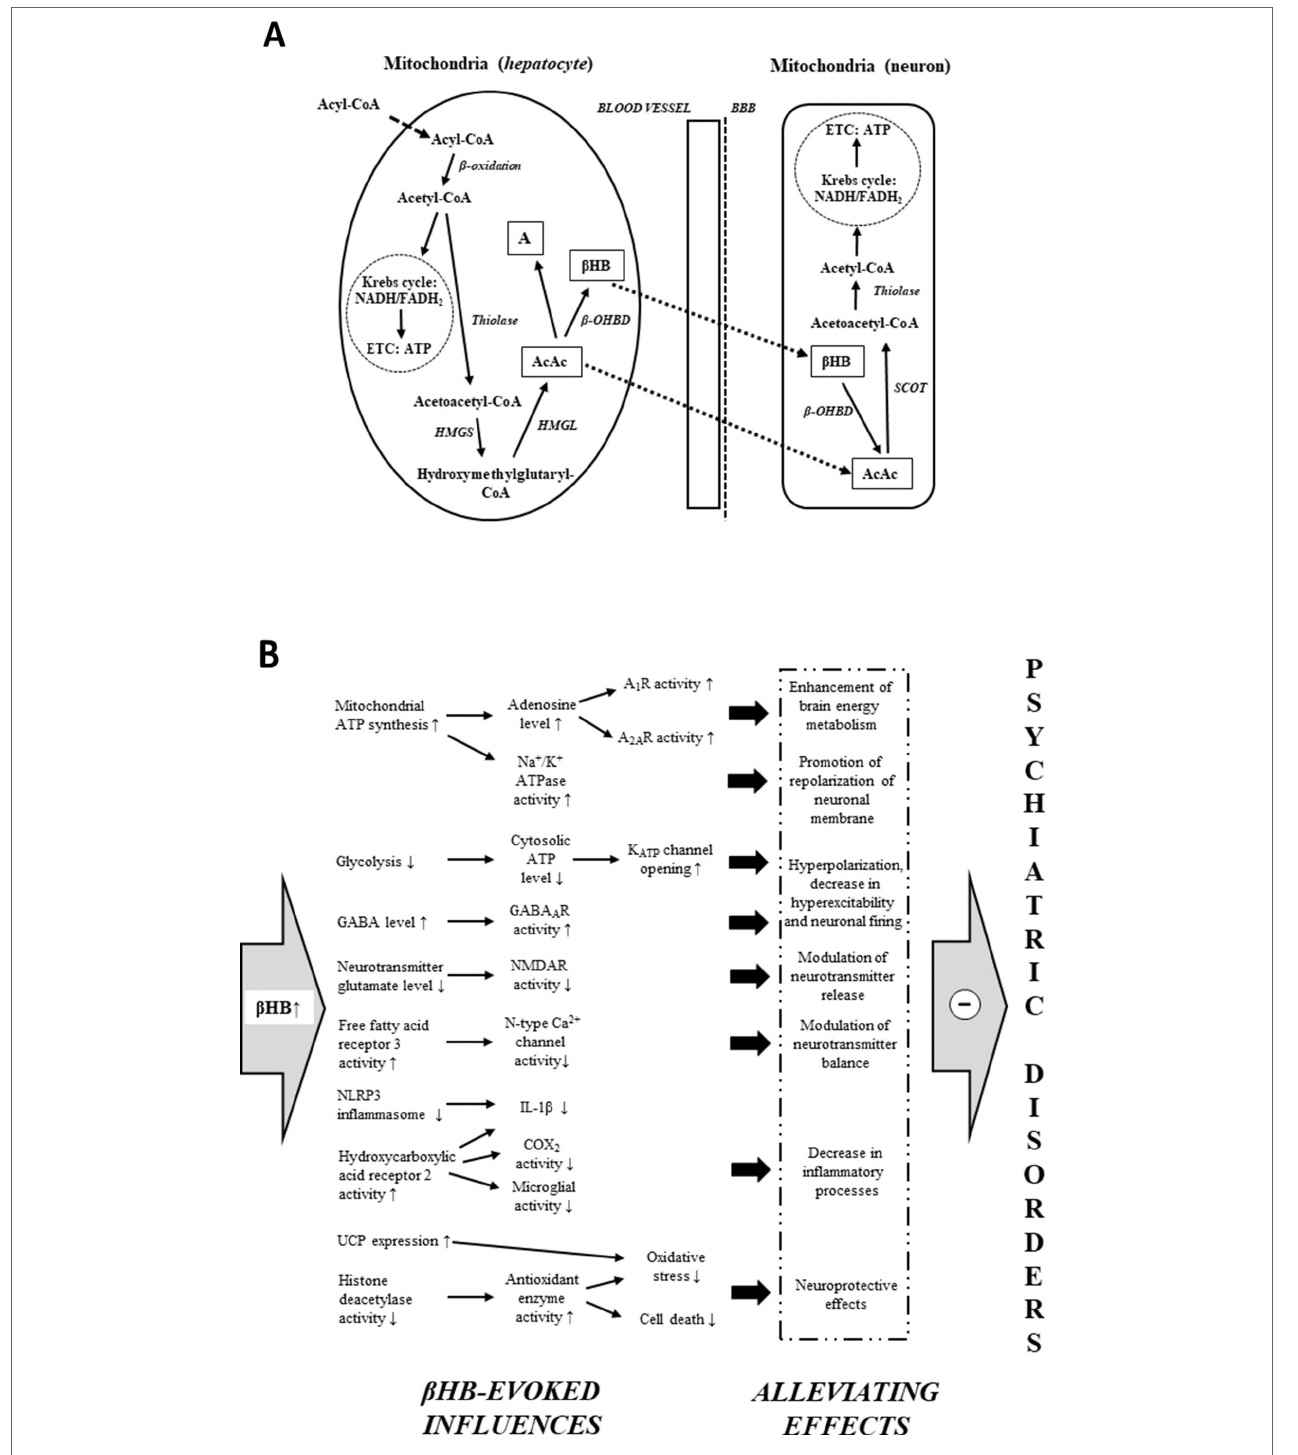
FIGURE 1 | Mitochondrial ketone body metabolism: ketogenesis in liver cells ( hepatocytes ) and ketolysis in brain cells (neuron) (A) . Main β HB-evoked metabolic effects and their consequences, which may evoke alleviating effects on different psychiatric diseases (B) (see text for more detailed putative mechanisms by which β HB may evoke alleviating effects on psychiatric diseases). Abbreviations: A, acetone; A 1 R and A 2A R, different types of adenosine receptors; AcAc, acetoacetate; ATP, adenosine triphosphate; BBB, blood–brain barrier; β HB, D-beta-hydroxybutyrate (R-3-hydroxybutyrate); β -OHBD, β HB dehydrogenase; COX-2, cyclooxygenase-2; ETC, electron transport chain; GABA, gamma-aminobutyric acid; HMGL, hydroxymethylglutaryl-CoA-lyase; HMGS, hydroxymethylglutaryl-CoA- synthase; IL-1 β , interleukin-1 β ; NADH/FADH 2 , nicotinamide adenine dinucleotide/flavin adenine dinucleotide; NLRP3, NOD-like receptor pyrin domain 3; NMDAR, N-methyl-D-aspartate receptor; SCOT, succinyl-CoA:3-ketoacid CoA transferase; thiolase, acetoacetyl-CoA-thiolase; UCP, uncoupling